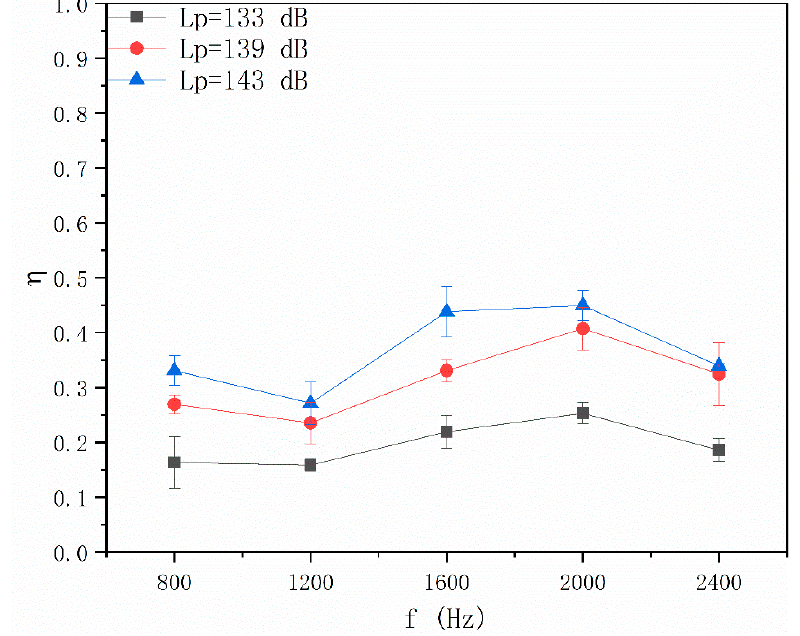
Figure 9. Reduction ratios of 2- μ m particles under different acoustic conditions.